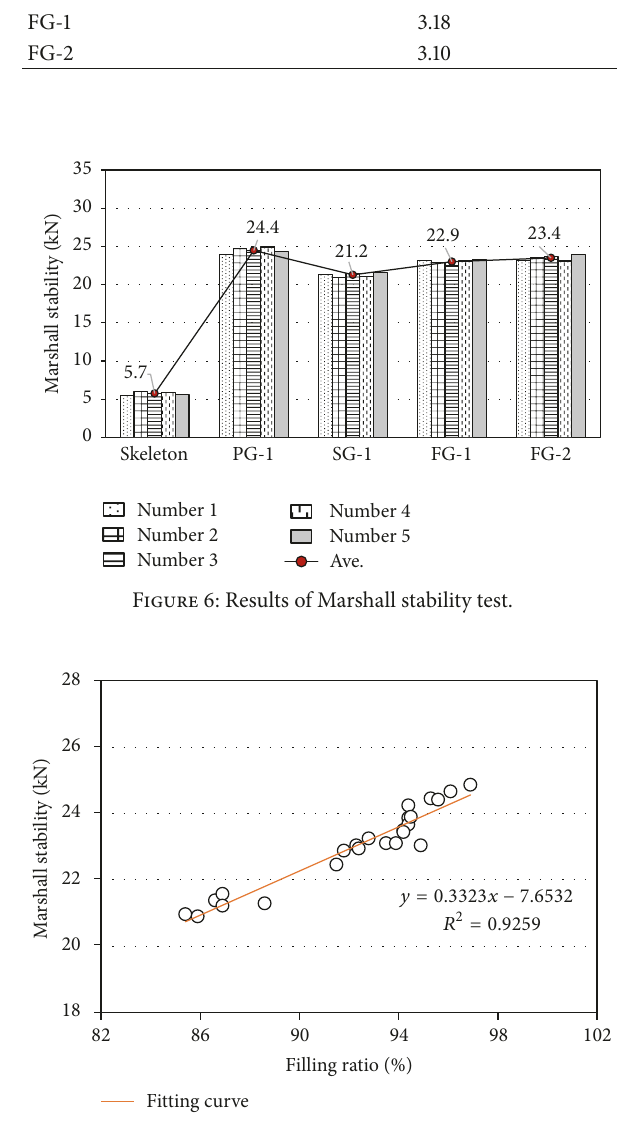
Figure 7: Relationship between Marshall stability and filling ratio of all semirigid pavement specimens.